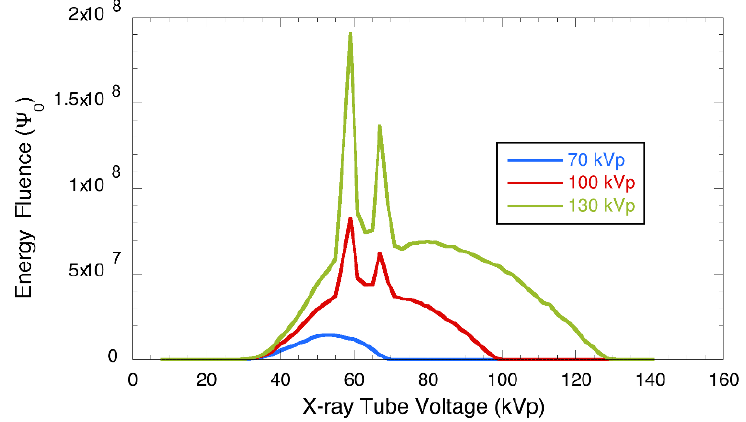
Ψ ) produced at 70, 100, and 130 produced at 70, 100, and 130 kVp. Figure 1. X-ray energy fluence spectra ( 0 ( 𝜳𝜳 𝟎𝟎 )